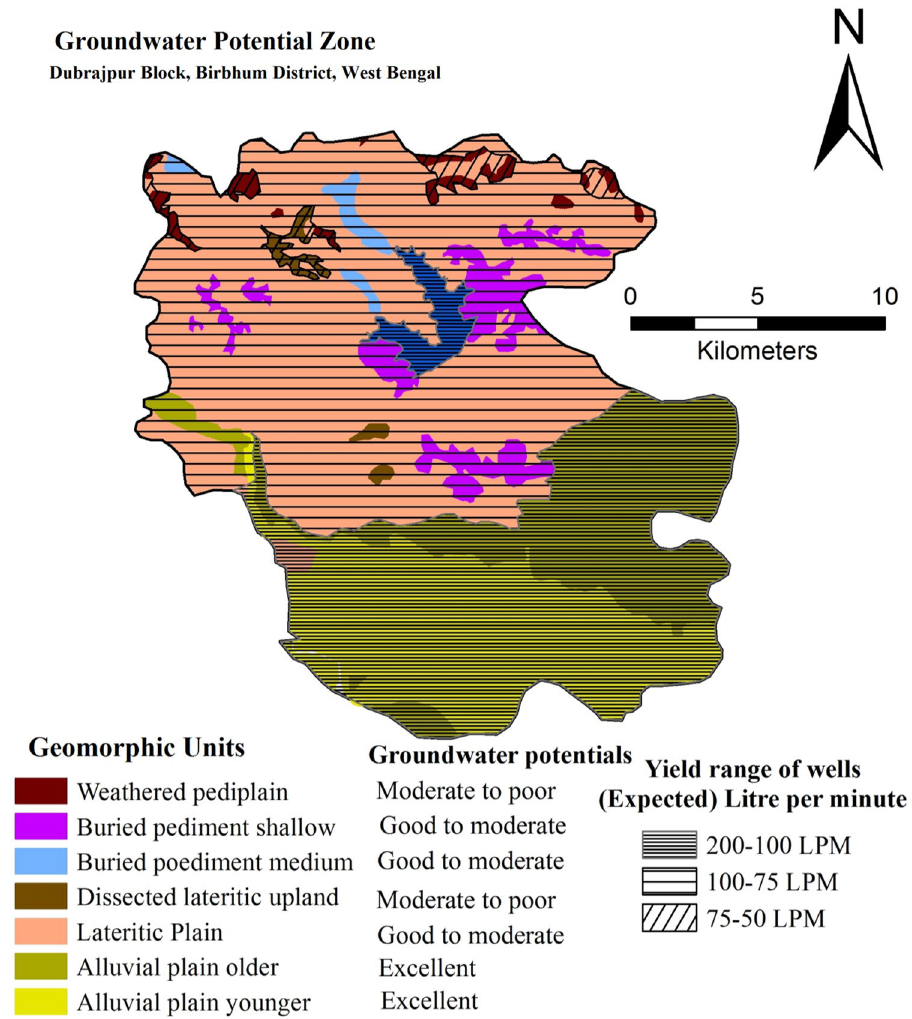
Fig. 4 Groundwater Potential Zone of the Study